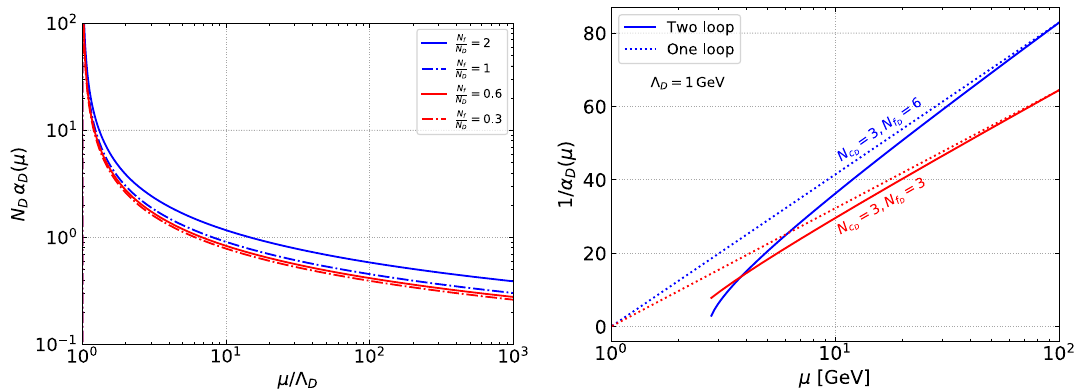
α (μ) , computed at one loop, as a function of μ/(cid:2) D D